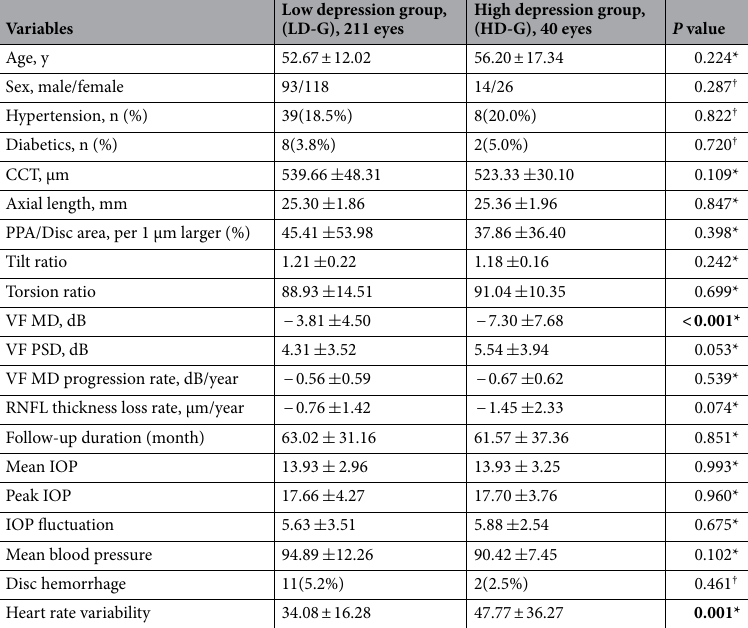
Table 5. Comparison of the demographics and test results between two groups divided according to the Beck depression inventory-II (BDI-II) scale. CCT, central corneal thickness; PPA, peripapillary atrophy; VF, visual field; MD, mean deviation; PSD, pattern standard deviation; RNFL, retinal nerve fiber layer; IOP, intraocular pressure. Statistically significant values appear in boldface. *The comparison was performed using independent samples t-test. † The comparison was performed using a chi-squared test. Continuous data are mean ± mean standard deviation unless otherwise